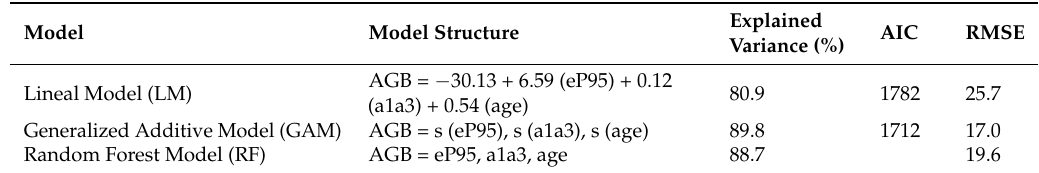
Table 3. Explained variance, AIC, and root mean squared error (RMSE) of the 10-fold cross-validation fit models for AGB in Mg ha − 1 .